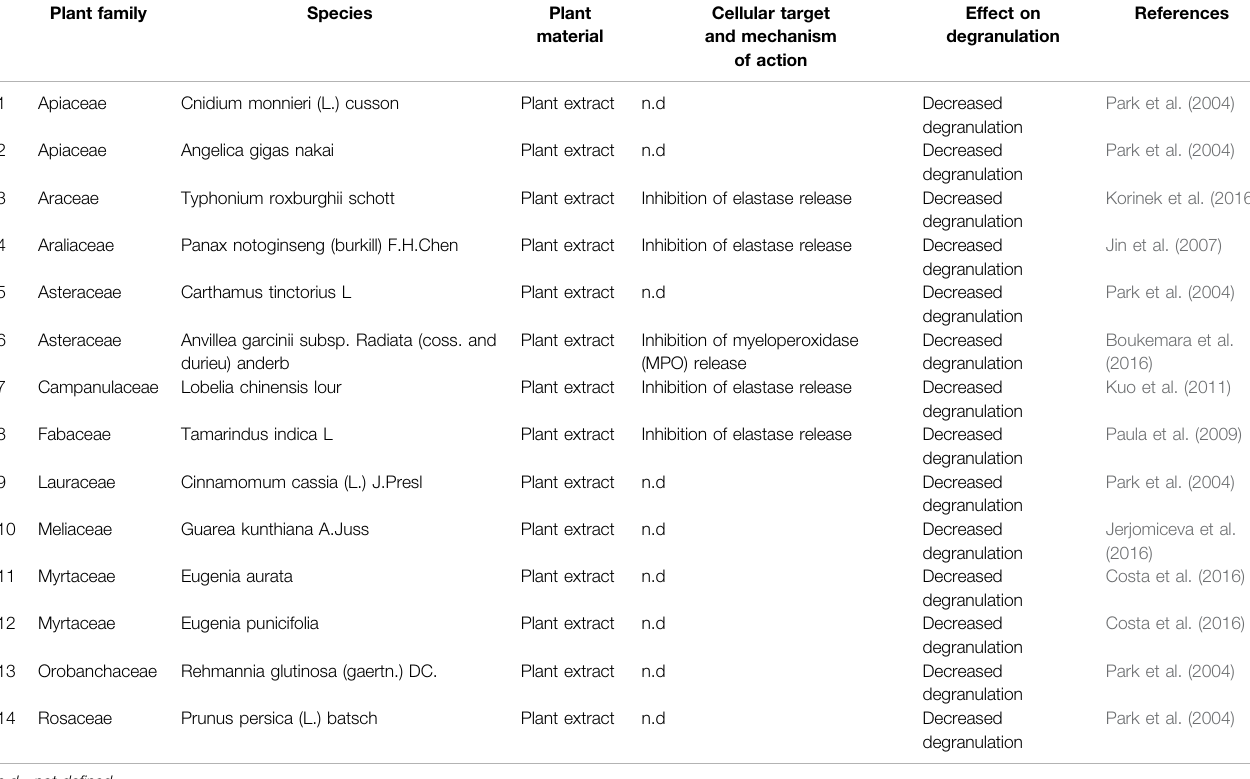
TABLE 4 | List of selected plant material with documented impact on degranulation of neutrophils. Plant family